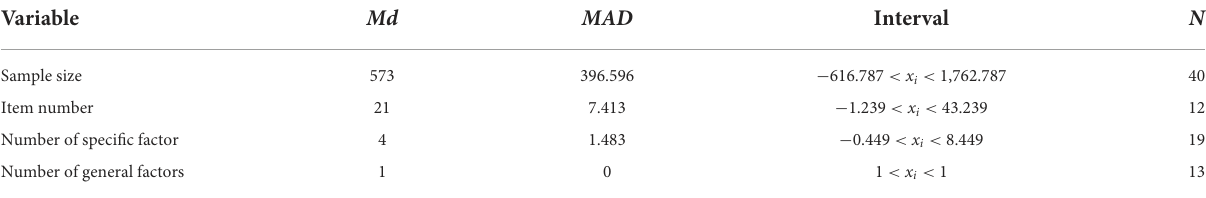
TABLE 9 Outlier detection